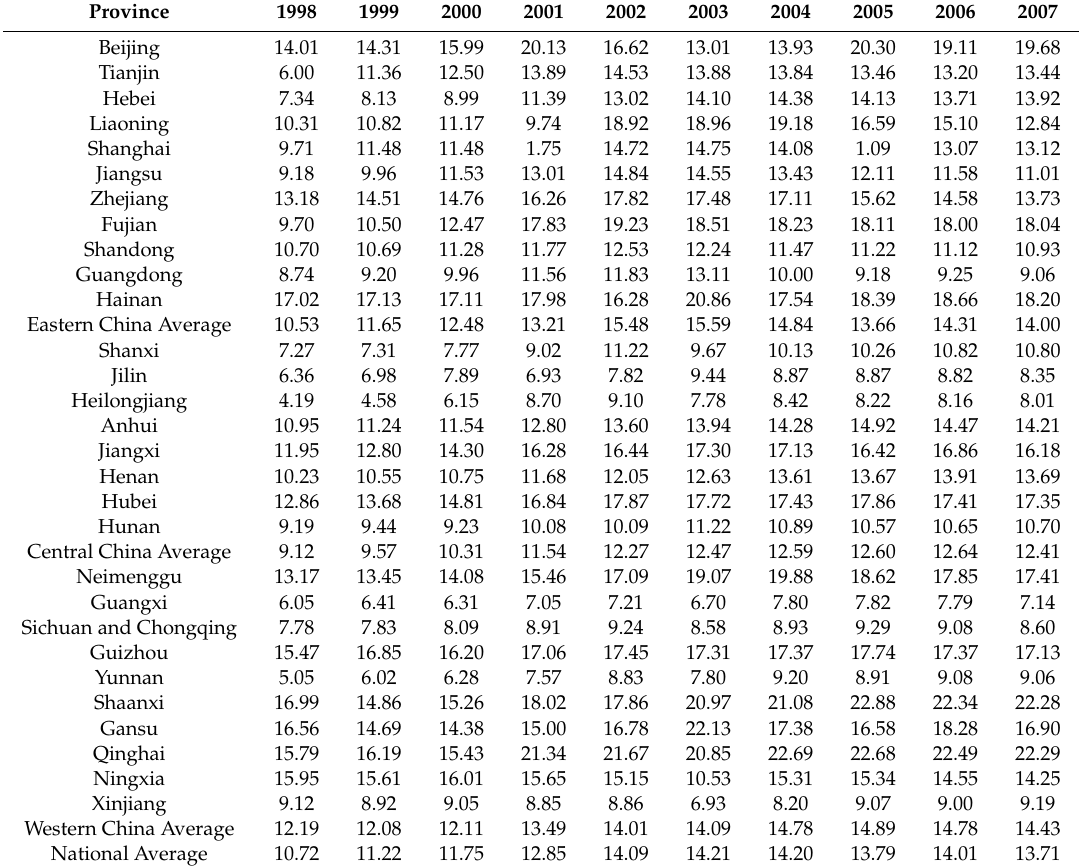
Table A1. 1998–2017 Provincial hidden economy scale (%) (Part 1).